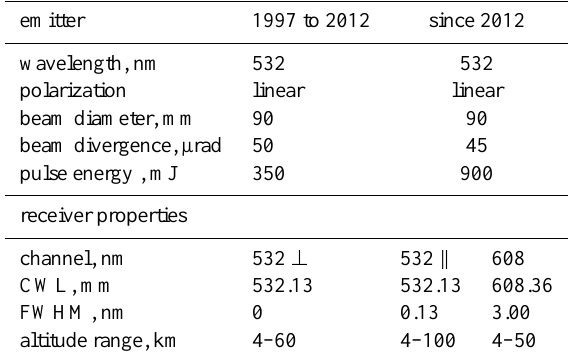
Table 1. Emitter properties and characteristics such as central wave- length (CWL), full width at half maximum (FWHM) of the receiver